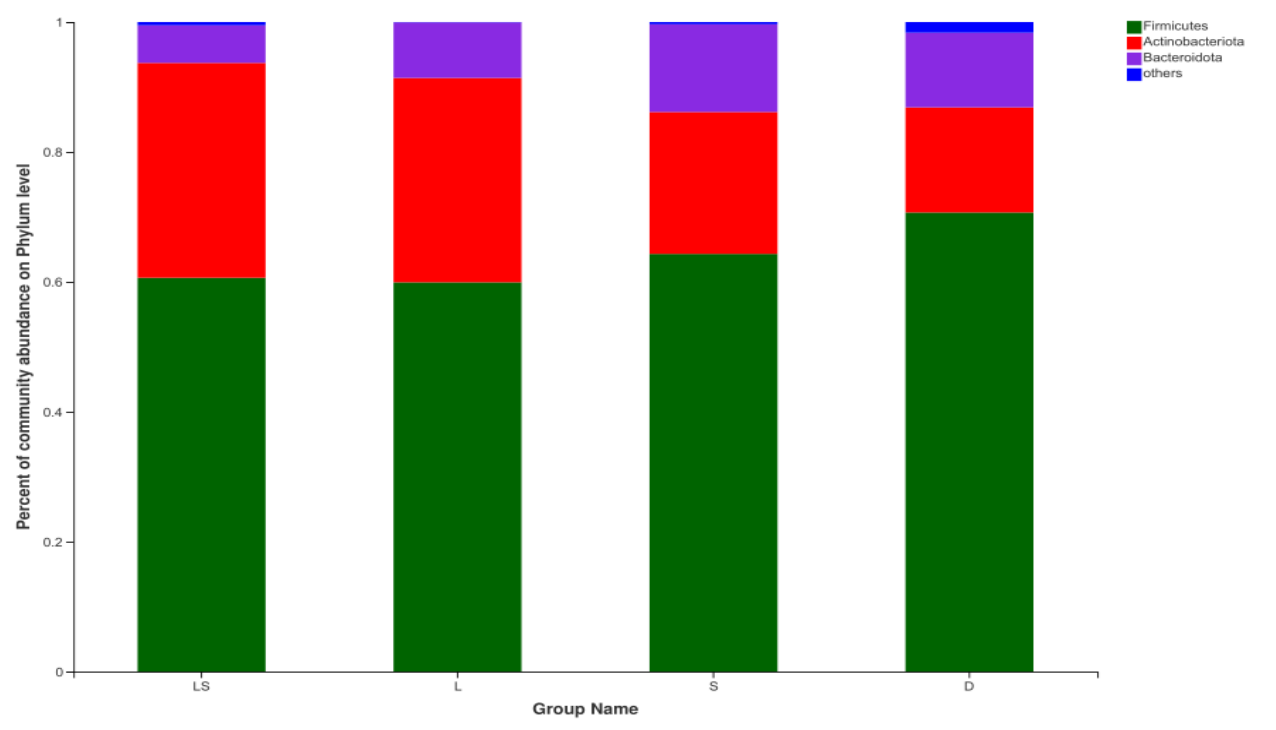
Figure 2. Relative abundance of bacterial groups from the LS, L, S, and D groups at the phylum level. LS group: lactic acid bacteria + yeast group; L group: lactic acid bacteria group; S group: yeast group; D group: control group.